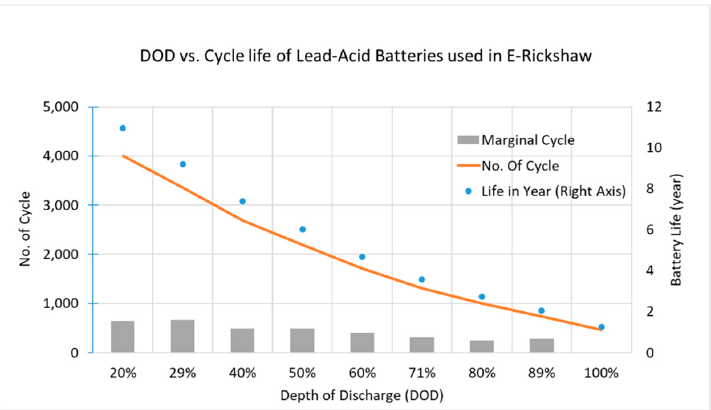
Figure 17. Depth of discharge vs cycle life (orange line) and equivalent life expectancy (blue dots) of LABs used in e-rickshaws. The grey bars show marginal cycles for every 10% additional DOD [53].